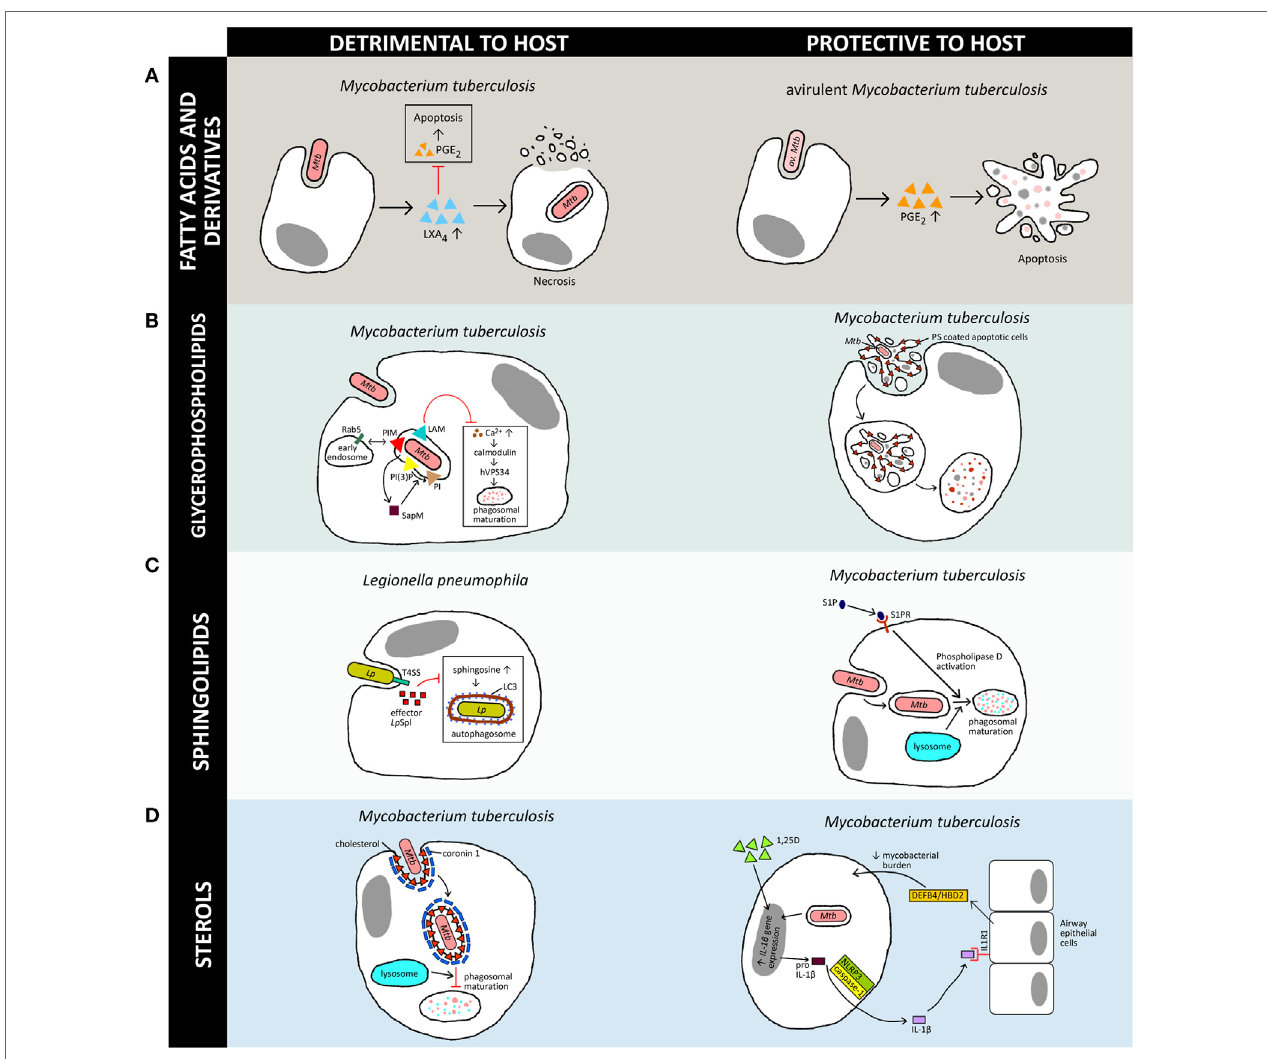
FiGURe 1 | Versatility of lipids in generation of host immune responses against various intracellular pathogens. The schematic diagram illustrates a simplified overview of how the four host-derived lipid classes discussed in this review can be a double-edged sword, either being exploited by the pathogen for its own survival or aiding the host in clearance of the bacteria. Note that there are multiple lipids involved in host–pathogen interactions but only a few representative examples are shown here, and further details can be found in the original works. [ (A) , left] Induction of LXA 4 by virulent M. tuberculosis ( Mtb ) inhibits PGE 2 signaling and promotes necrosis in macrophages (18), whereas [ (A) , right] induction of PGE 2 secretion by avirulent M. tuberculosis (av. Mtb )-infected macrophages leads to apoptosis and protects against mitochondrial inner membrane damage (19). [ (B) , left] Mtb manipulates host phosphoinositides metabolism to promote their survival in macrophages via inhibition of phagosomal maturation. Mycobacterial phosphatidylinositol mannoside (PIM) stimulates early endosomal fusion by recruiting Rab5. Inhibition of Ca 2 + increase by Mycobacterium lipoarabinomannan (LAM) further blocks phagosomal maturation as Ca 2 + is required for calmodulin phosphatidylinositol 3-kinase hVPS34 signaling cascade activation. SapM secreted by Mycobacterium inhibits phagosomal-late endosome fusion by hydrolyzing phosphatidylinositol 3-phosphate (20–23). However, [ (B) , right] redistribution of phosphatidylserine (PS) during apoptosis leads to efferocytosis and restricts the growth of Mtb (24). [ (C) , left] Effector Lp Spl from Legionella pneumophila ( Lp ) mimics host sphingosine-1-phosphate (S1P) lyase and prevents an increase in sphingosine levels in infected macrophages, inhibiting autophagy (25). On the other hand, [ (C) , right] S1P is essential for bacterial clearance as it promotes acidification of Mycobacterium -containing phagosomes via phospholipase D activation, which leads to phagosomal maturation and killing of Mtb (26). [ (D) , left] Accumulation of cholesterol at the Mtb uptake site recruits coronin 1 protein, which inhibits phagosomal maturation (27). [ (D) , right] The active metabolite of vitamin D (1,25D) controls Mtb infection via macrophage–epithelial paracrine signaling. IL-1 β secreted through NLRP3/caspase-1 inflammasome signaling cascade stimulates epithelial cells to produce antimicrobial peptide DEFB4/HBD2, which reduces mycobacterial burden in macrophages (28). In this schematic diagram, triangles represent lipids whereas squares represent